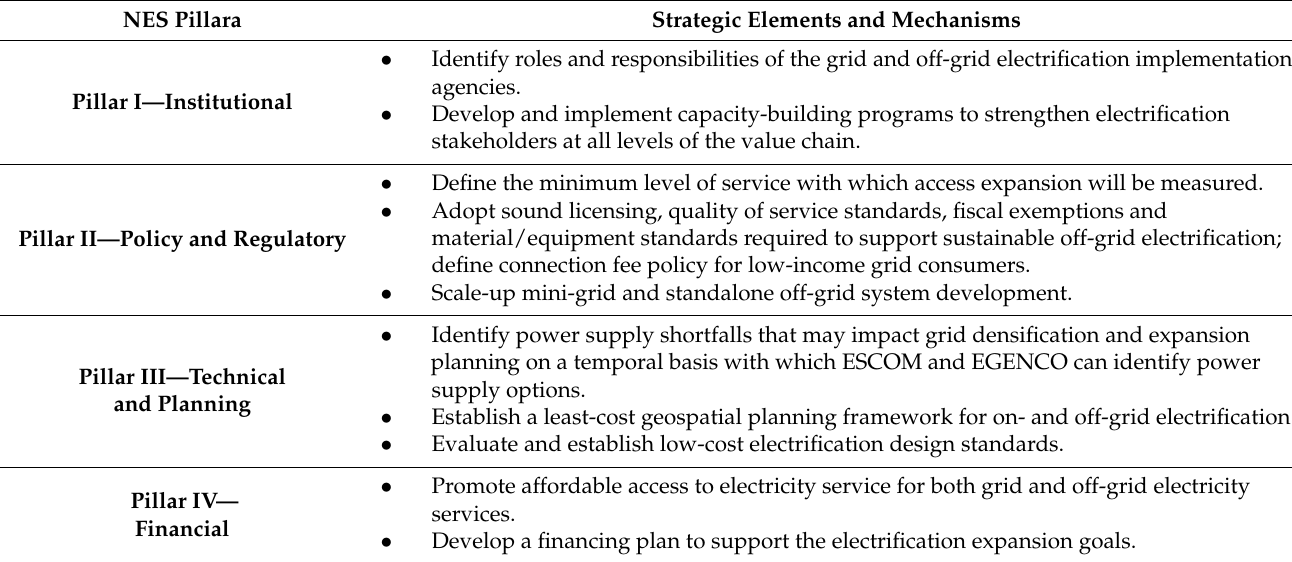
Table 5. Summary of Malawian national electrification strategy pillars (adapted from [2]). NES Pillara Strategic Elements and